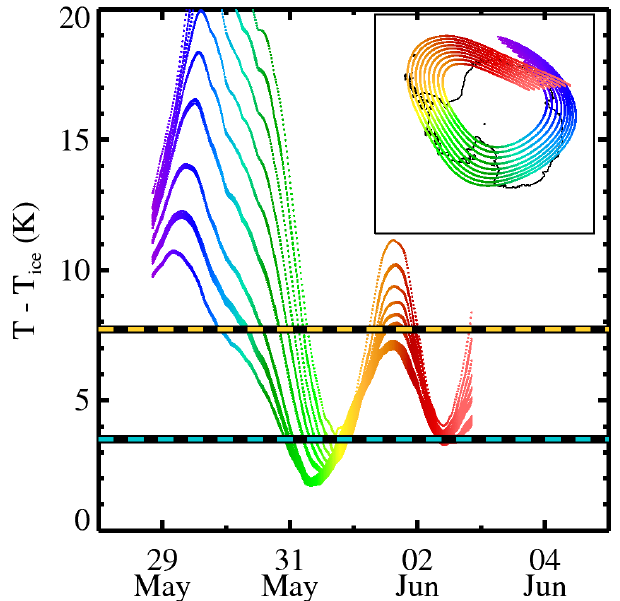
Fig. 17. Scatter plot of the depolarization vs. normalized backscat- ter for the period 28 May–3 June 2008, showing the PSC types iden- tified by CALIOP (MIX1 (green), MIX2 (yellow), LIQ (cyan), ICE (blue)) and including the enhanced-NAT sub-category (NATE (red)) at an altitude of 20–22km.